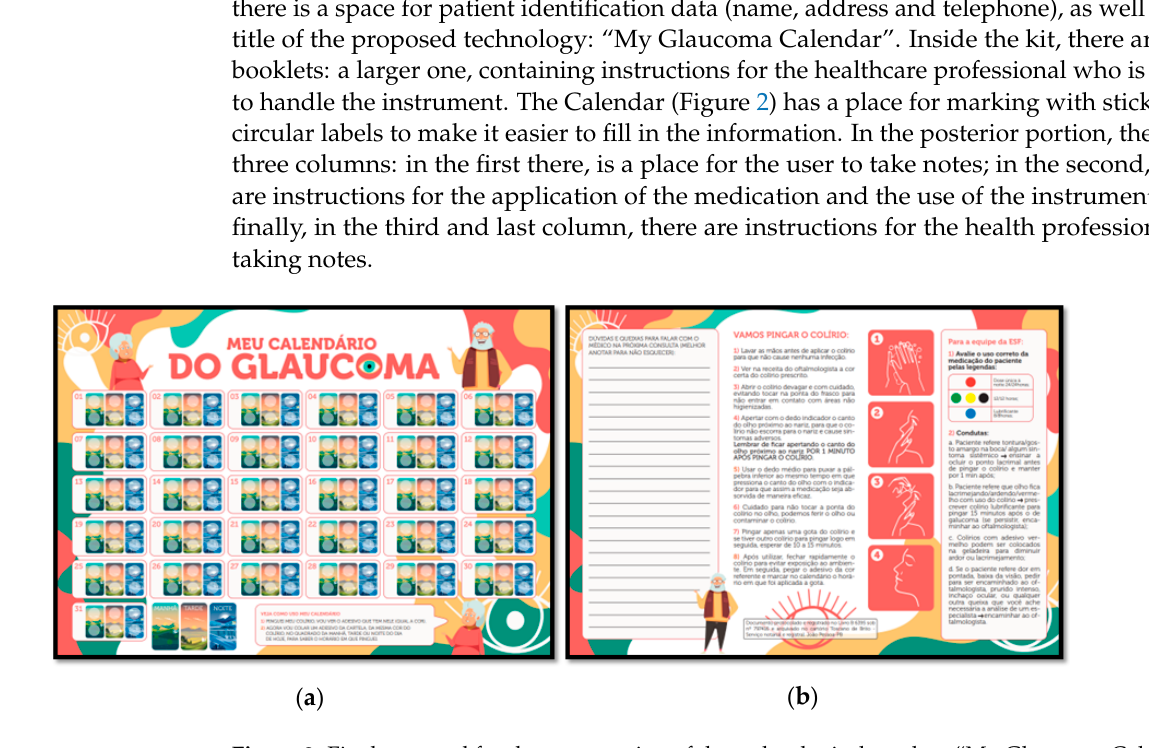
Figure 2. Final proposal for the construction of the technological product “My Glaucoma Calendar”.